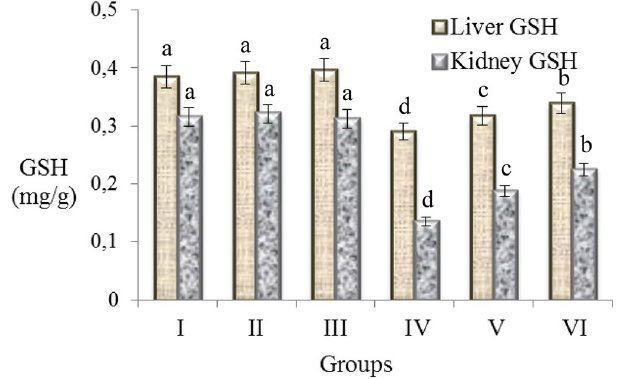
Figure 4. Effects of AFB 2 and resveratrol on the levels of GSH, a potent endogenous antioxidant, in liver and kidney cells. Group I: control, Group II: 10 mg/kg b.w resveratrol, Group III: 20 mg/kg b.w resveratrol, Group IV: 20 µg/kg b.w AFB 2 , Group V: 10 mg/kg b.w resveratrol + 20 µg/kg b.w AFB 2 , Group VI: 20 mg/kg b.w resveratrol + 20 µg/kg b.w AFB 2 . Each histogram is a decimal average. The vertical lines on the bars indicate the standard error. Different letters (a–d) indicated averages p < 0.05 is